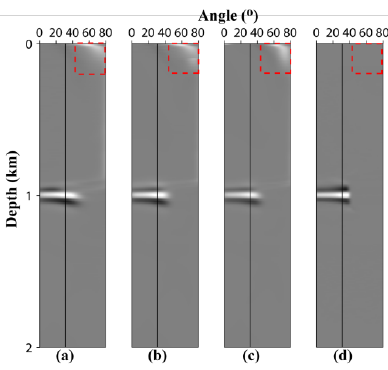
Figure 4. Angle gathers at 3 km of which shots are from 2.4–3 km of the two-layer model in Figure